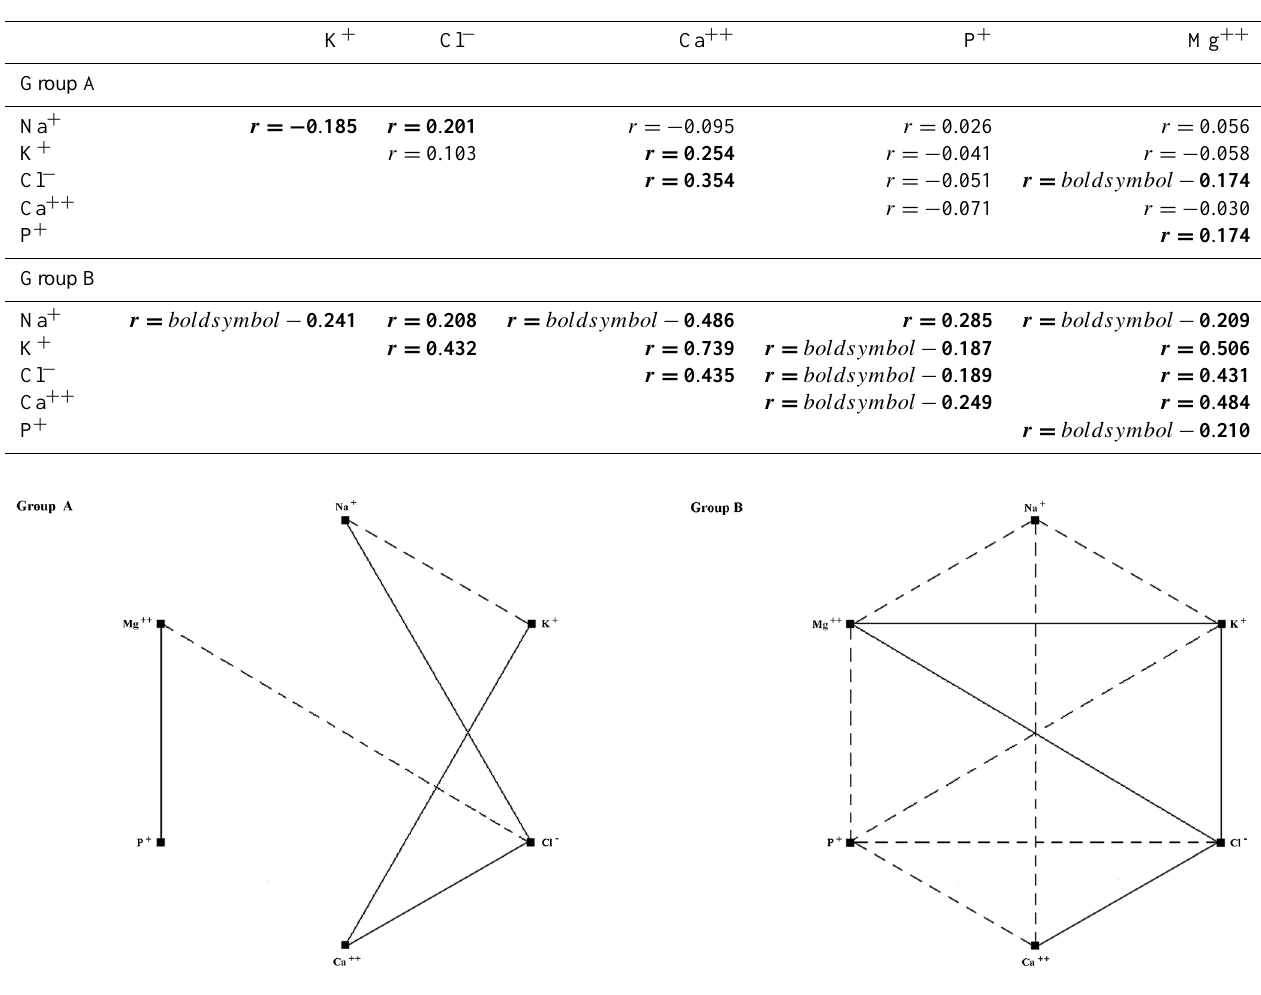
Figure 2. Graphical representation of statistical correlations obtained between studied electrolytes in pregnant (Group A) and control (Group B) mares. Continuous lines indicate positive correlations and dotted lines indicate negative